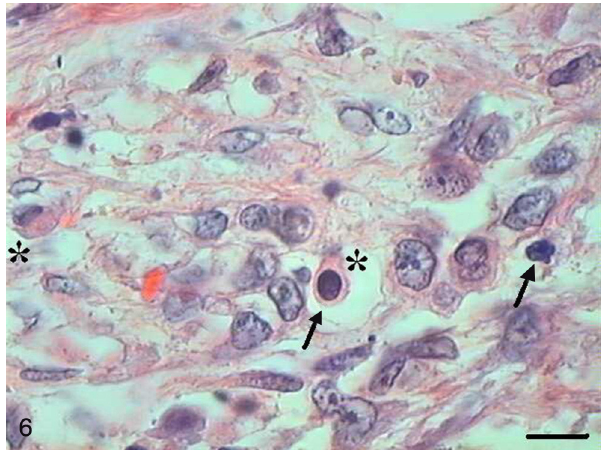
Figure 6 Grade III squamous carcinoma cells. Micrograph of grade III squamous carcinoma cells with presence of a few apop- totic cells with condensation of cytoplasm (arrows) and anoikis (*) (HE, bar = 10 (cid:2)